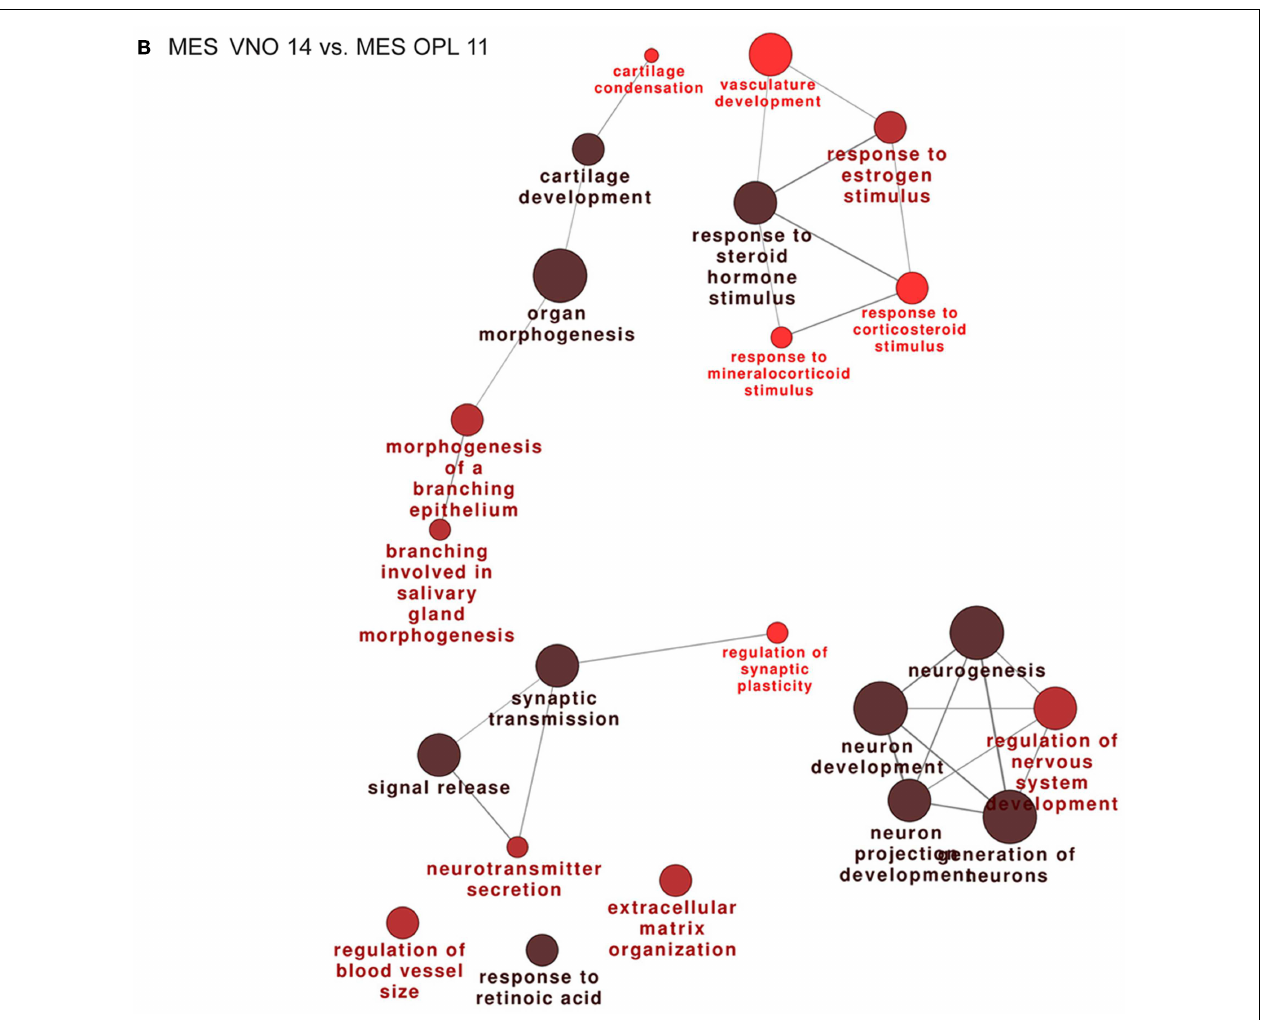
FIGURE 2 | Functional categorization of genes differentially expressed in the mesenchyme adjacent the OE andVNO, during development . Significantly over-represented functional categories of the DEGs detected in